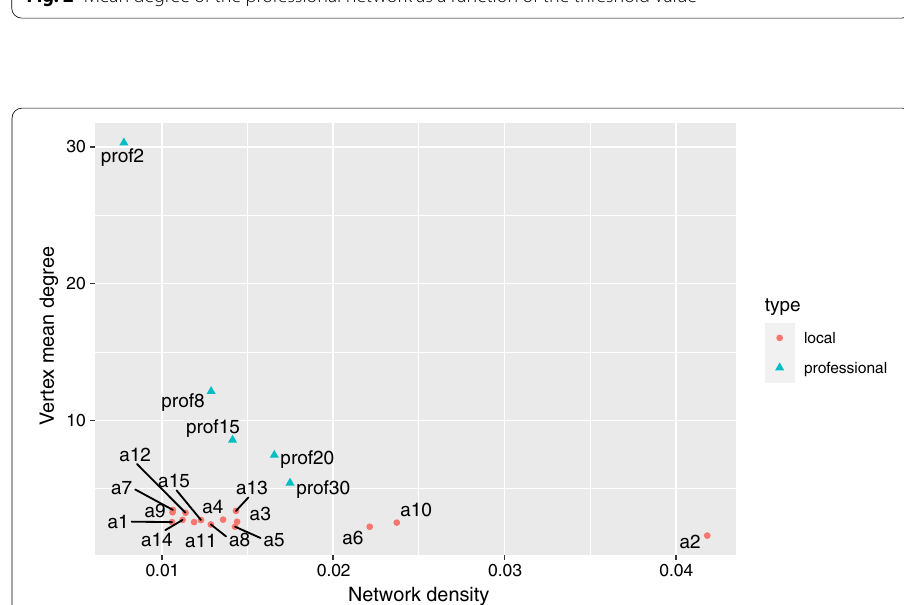
Fig. 2 Mean degree of the professional network as a function of the threshold value